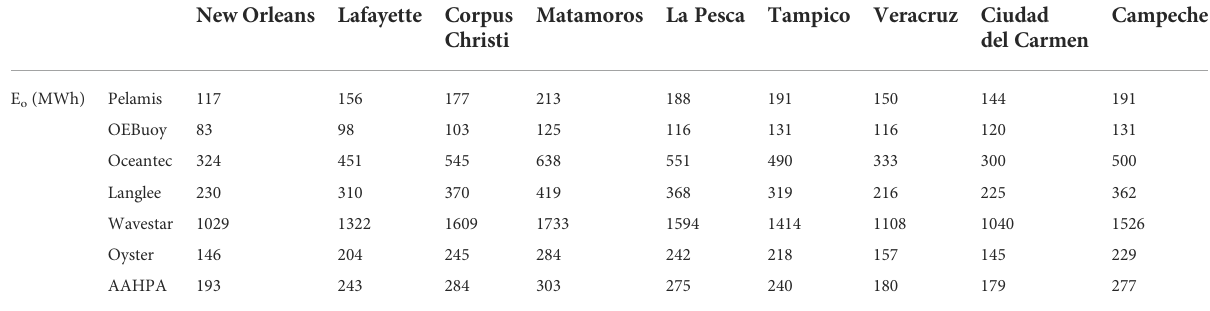
TABLE 3 Annual energy production at each site in the